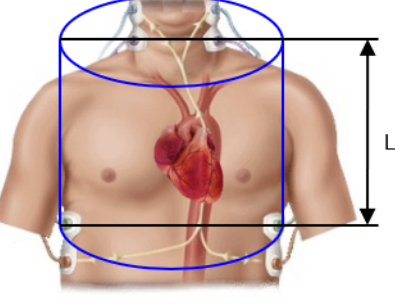
Figure 1. Cylindrical chest model according to Kubicek. L corresponds to the length between voltage electrodes applied during the ICG